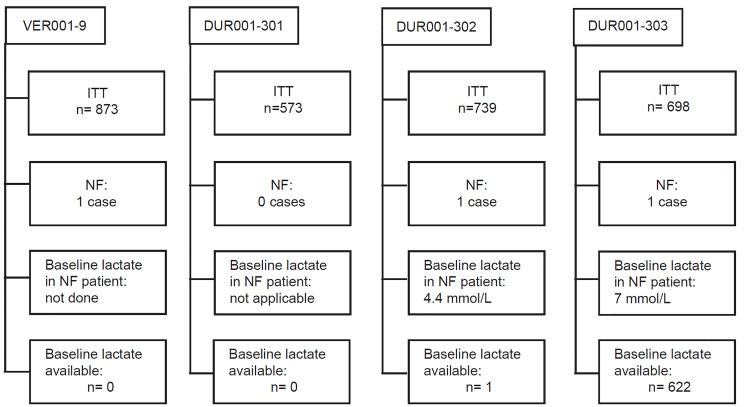
Incidence of necrotizing fasciitis and baseline lactate levels in intent-to-treat population.ITT, intent-to-treat; NF, necrotizing fasciitis; mmol/L, millimoles per liter.